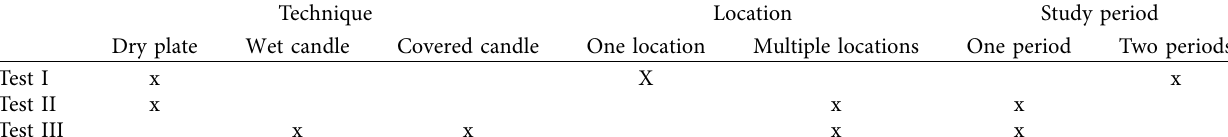
Table 1: Summary of the different techniques, locations, and study periods involved in the three tests.